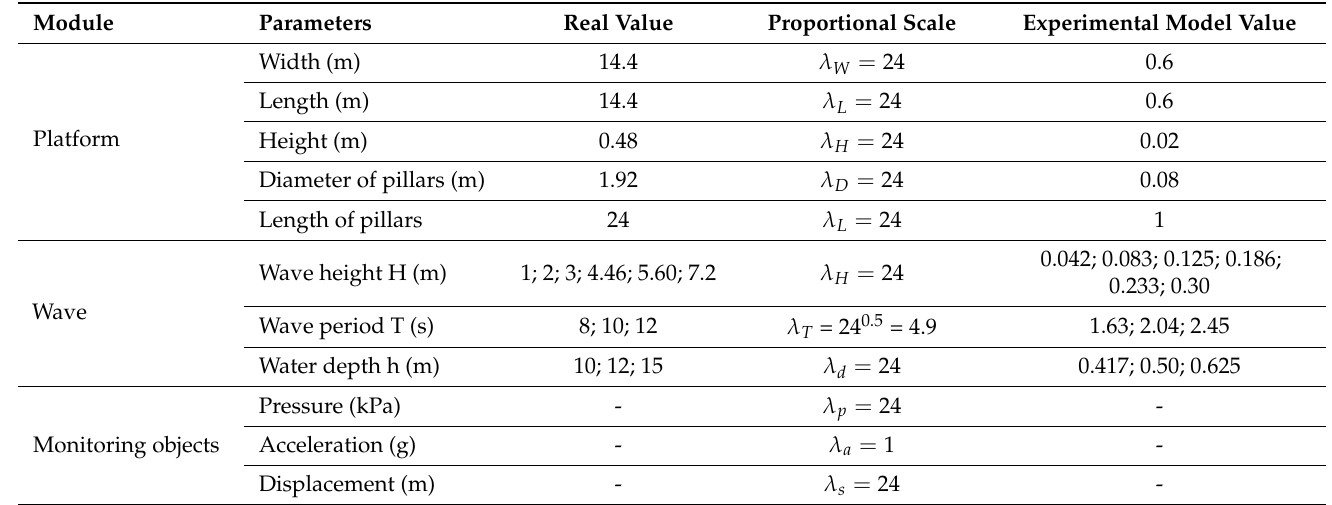
Table 2. The corresponding parameters of the prototype and the experimental